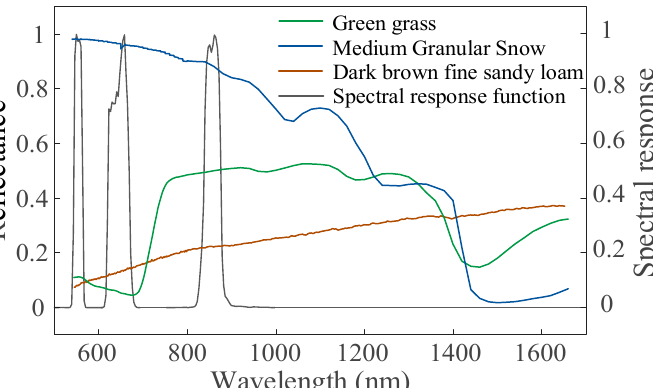
Figure 3. Schematic diagram of endmember reflectance spectra and the spectral response of the MODIS sensor.